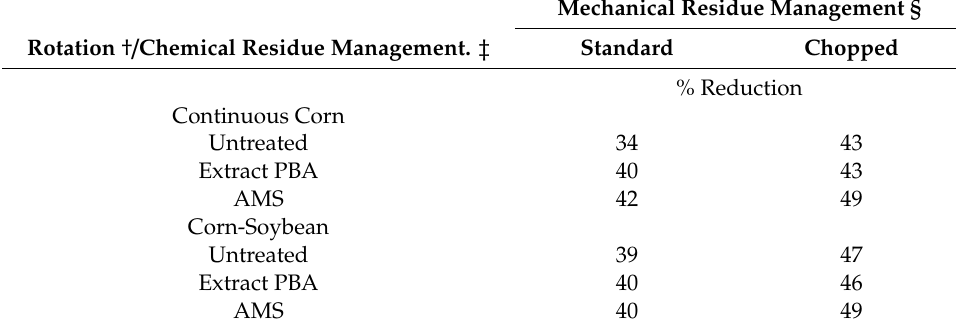
Table 4. Corn residue degradation over winter as influenced by rotation and mechanical or chemical residue management. Data represent the reduction in dry matter weight of the initial residue subsamples from the previous season post-harvest (fall 2016 and 2017) versus the weight remaining preplant (spring 2017 and 2018) in field-located mesh bags at Champaign,